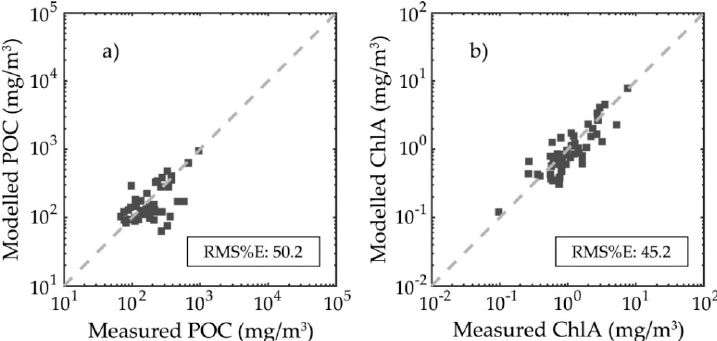
Figure 11. Comparison of ( a ) POC and ( b ) ChlA values as determined by the optimized models of Equations (17) and (18) vs. their respective measured values. The dashed grey lines indicate the 1:1 relationship.